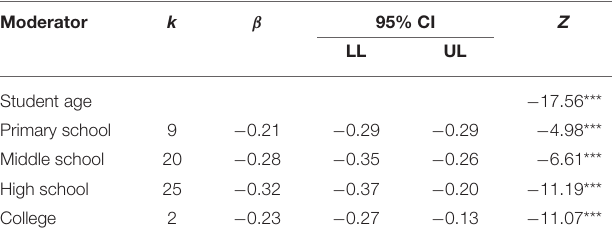
TABLE 3 | Student age as moderator of the BFLPE. TABLE 4 | ASC domain as moderator of the